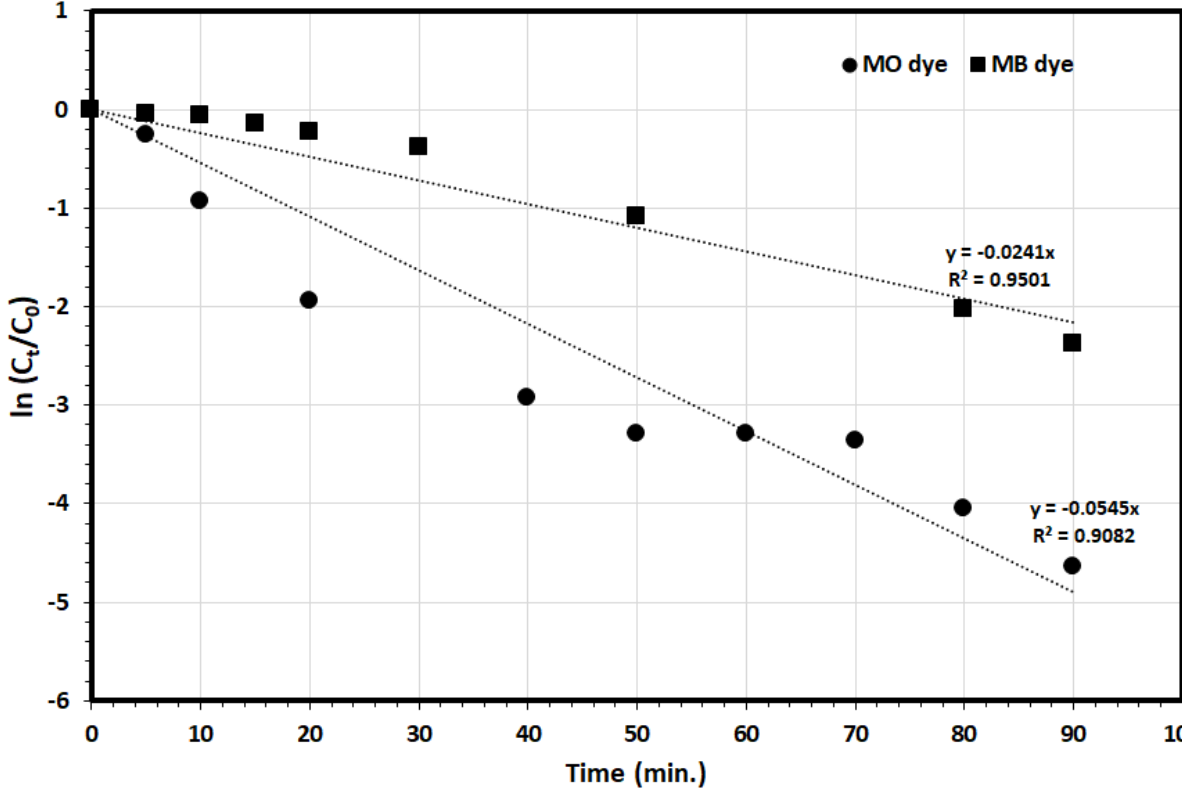
Figure 9. Kinetic plots for the photocatalytic degradation of MO and MB over BMW ZnO NPs. (Experimental conditions: 20.0 mL solution, pH 6, BMW ZnO NPs mass 15.0 mg, 298 K and [MO] 5.0 mg/L, [MB] 5.0 mg/L).